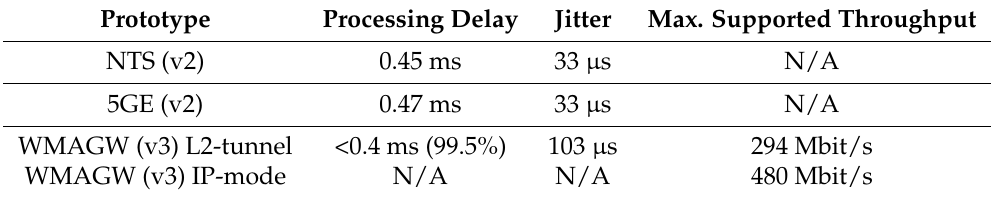
Table 2. Calibrated operational performance specifications of the implemented